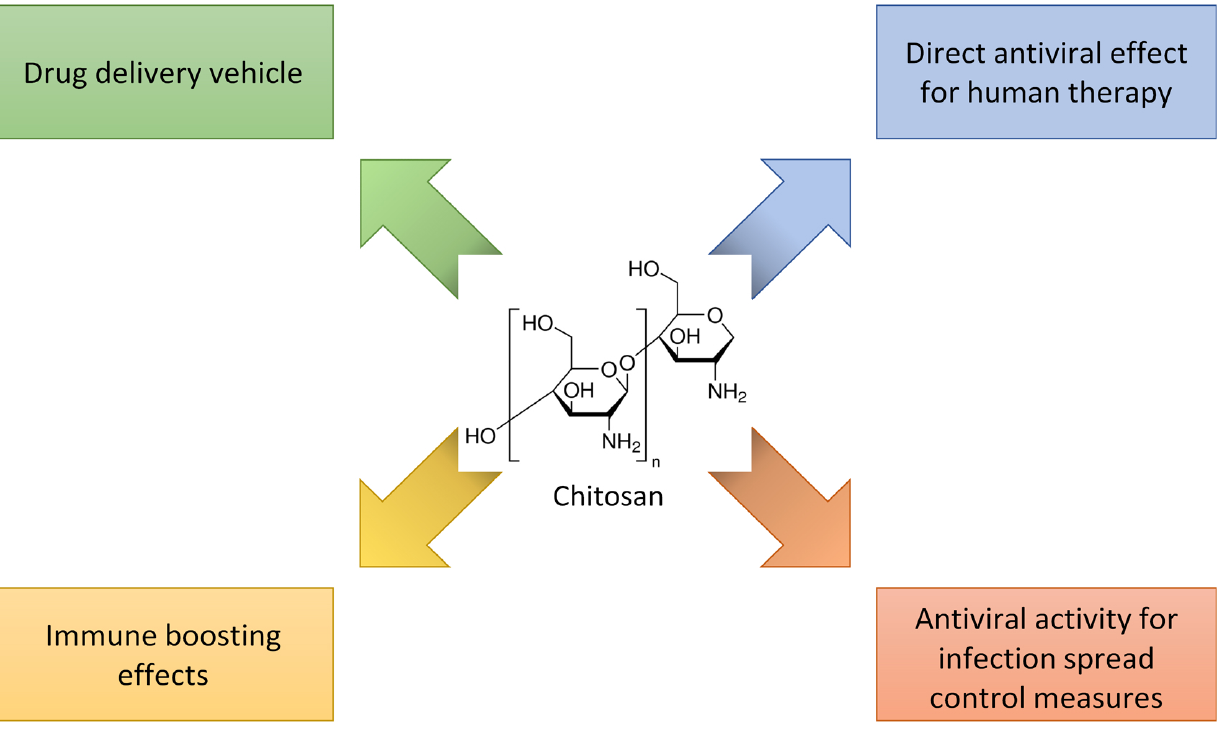
Figure 10. Possible applications of chitosan in